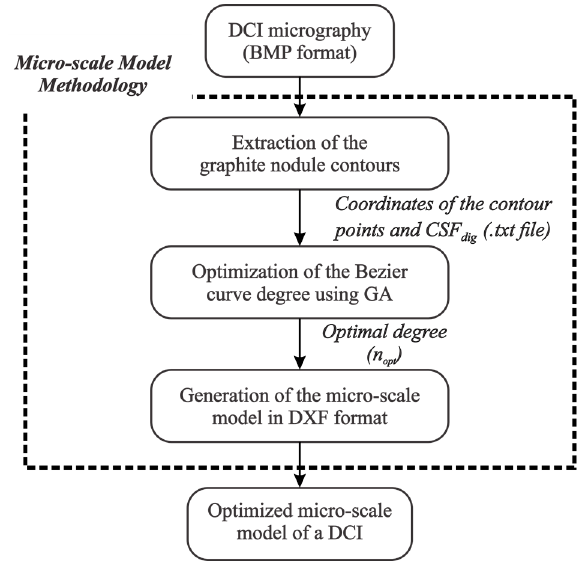
Figure 3. General scheme of the methodology followed.